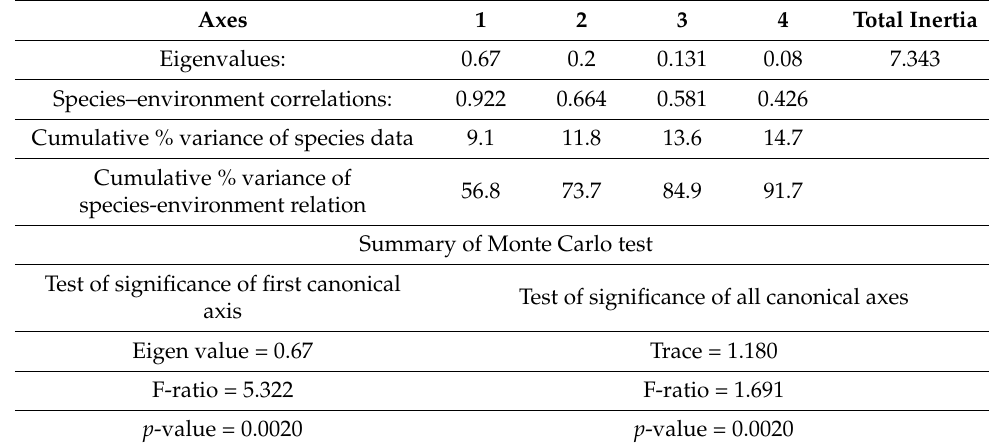
Table 3. CCA bi-plot summary of the 30 climber plant species with environmental